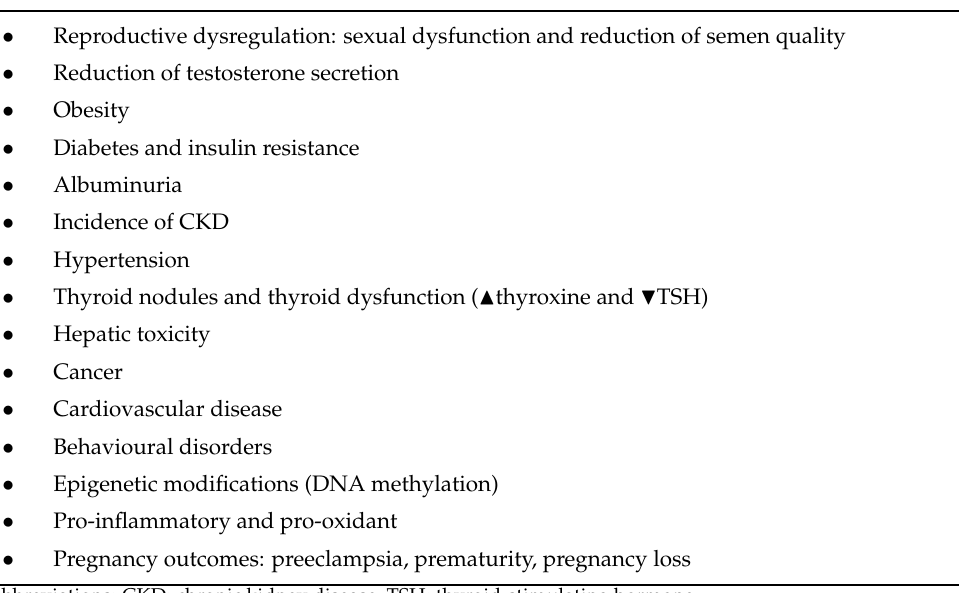
Table 1. BPA potential